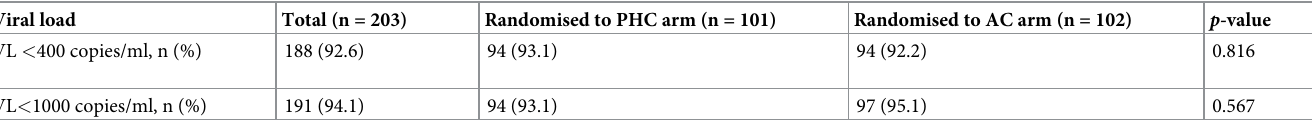
Table 2. Comparison of VL outcomes between trial arms through 12 months post-ART initiation in those who completed the final study visit. Viral load